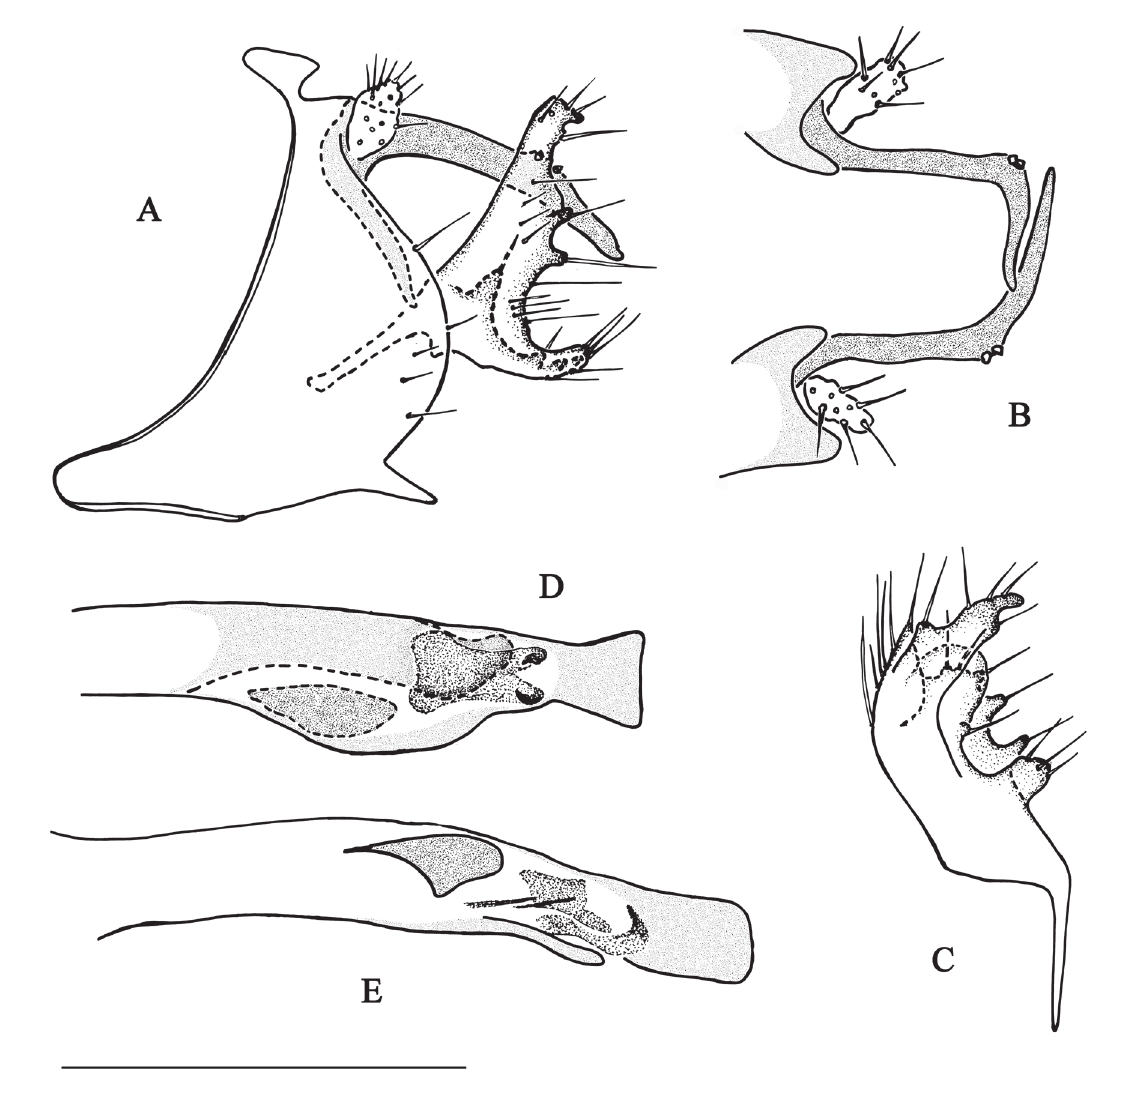
Fig. 5. Chimarra forcellinii sp. nov. A–B . Abdominal segments IX and X. A . Lateral view. B . Dorsal view. C . Inferior appendage, dorsal view. D–E . Apex of the phallic apparatus. D . Dorsal view. E . Lateral view. Scale bar = 0.5